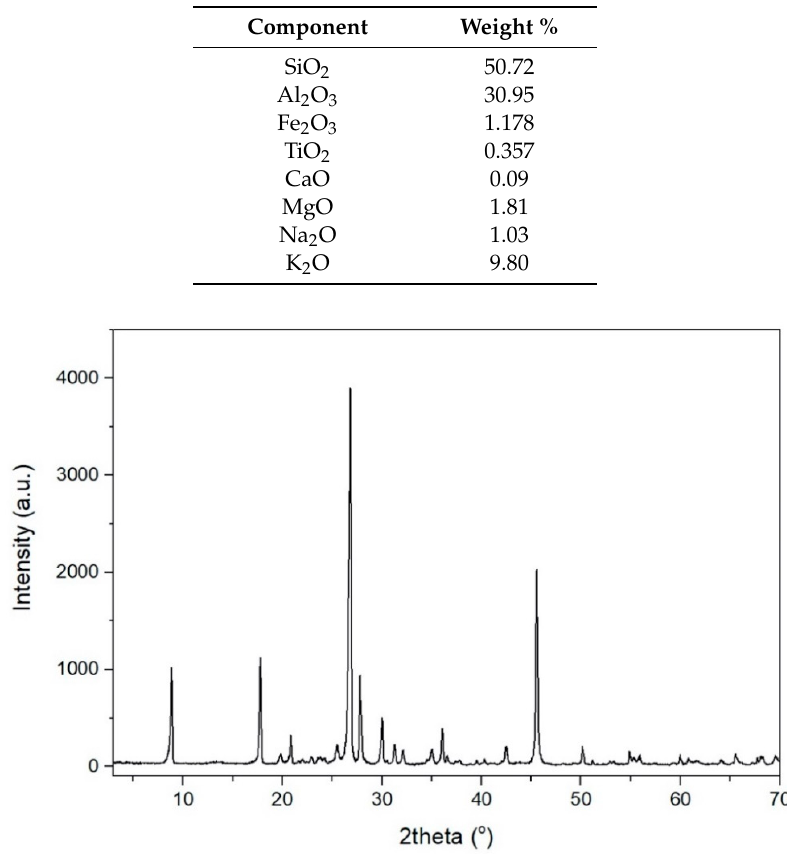
Table 1. Chemical composition of muscovite.